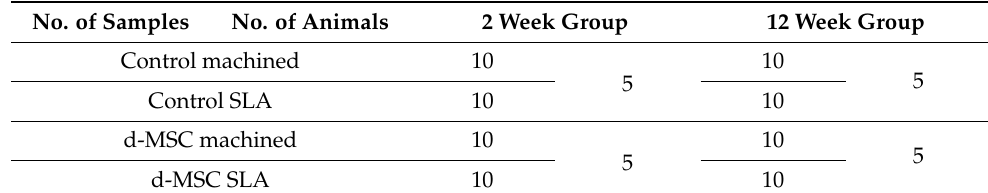
Table 2. The experimental design and classification of animal groups.